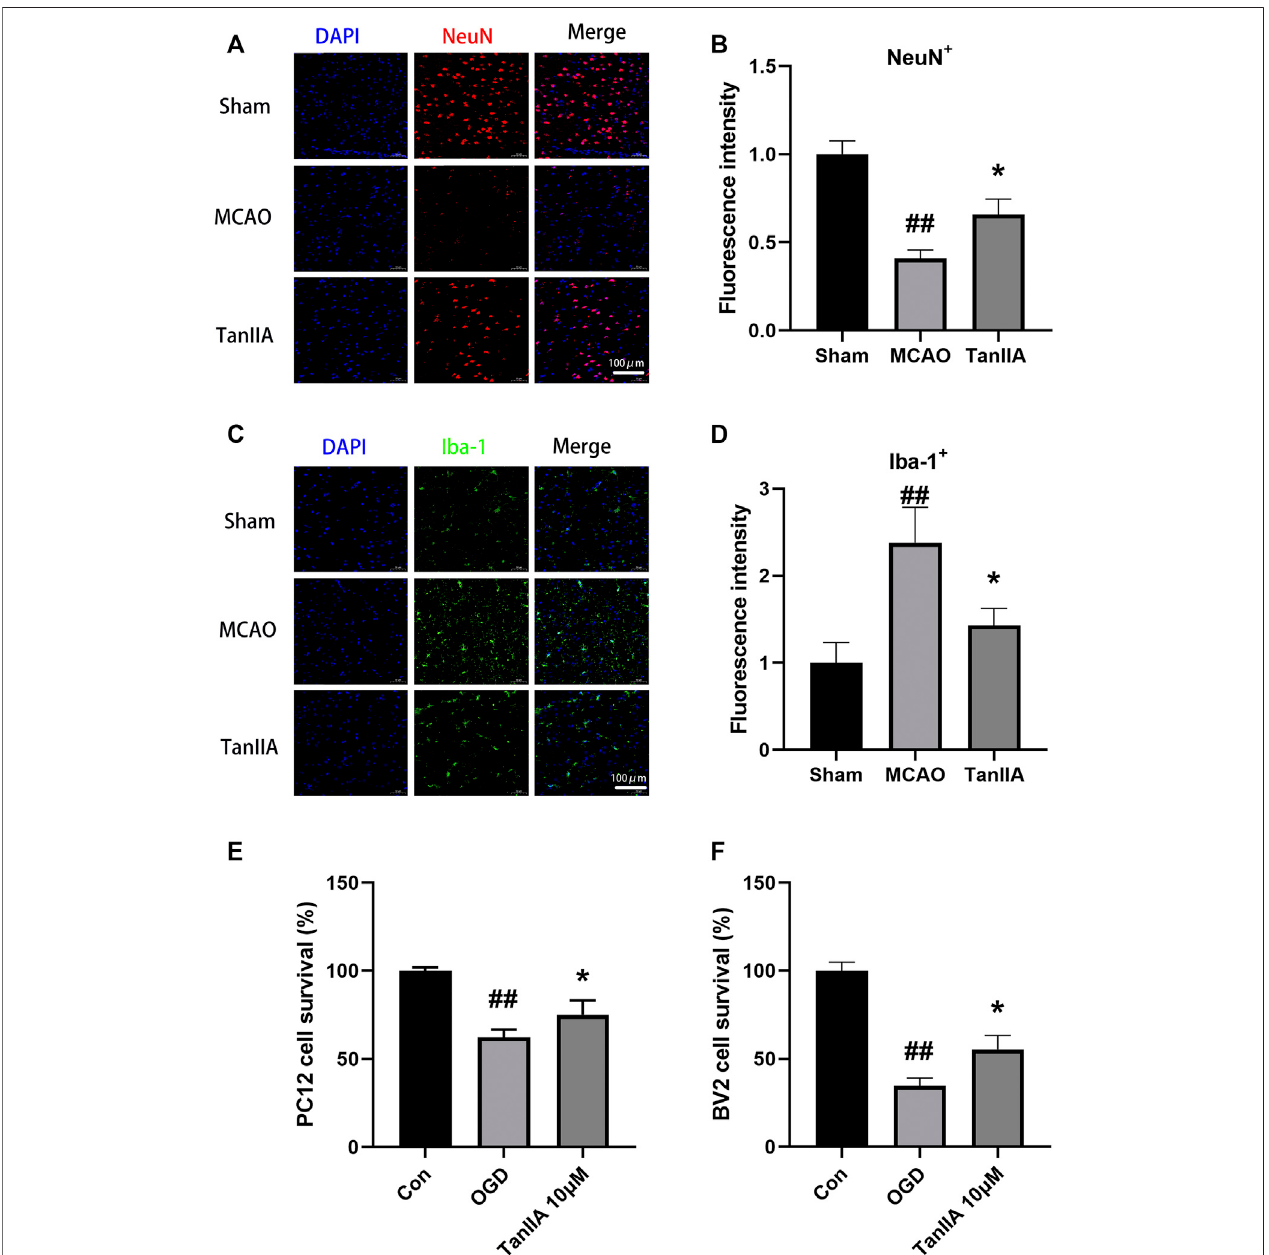
FIGURE 4 | Effects of Tanshinone IIA on neuroprotection in vivo and in vitro . Immuno fl uorescence staining was used to detect the levels of NeuN-positive neuron (A) and Iba-1-positive microglia (C) in rat ischemic penumbra area. NeuN was shown as red, Iba-1 was shown as green and DAPI was shown as blue (Scale bar: 100 μ m). (B) Fluorescence intensity of NeuN-positive neuron in rat ischemic penumbra area. (D) Fluorescence intensity of Iba-1-positive microglia in rat ischemic penumbra area. ## p < 0.01, compared with the Sham group, * p < 0.05, compared with the MCAO group. Sham, sham operation group; MCAO, middle cerebral artery occlusion; TanIIA, Tanshinone IIA, n (cid:1) 3. OGD-induced BV2 cells were treated with Tanshinone IIA. CCK-8 assay was used to measure the cell survival of PC12 cells (E) andBV2cells (F) afteroxygen-glucosedeprivation(OGD).## p < 0.01,comparedwiththecontrolgroup,* p < 0.05,comparedwiththeOGDgroup.Con,control group; OGD, oxygen-glucose deprivation; TanIIA, Tanshinone IIA, n (cid:1) 6.